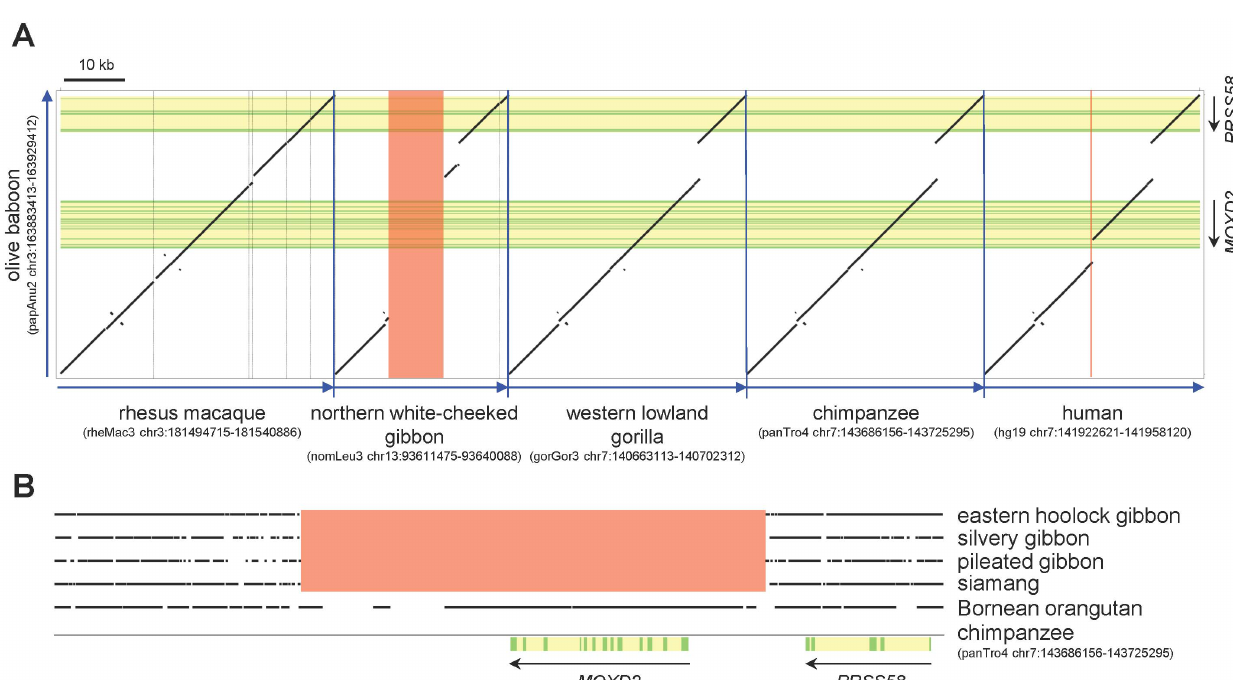
Figure 1. Phylogenetic tree of the species investigated in this study. The major groups are indicated either on the branch or to the right. Species with a mutated MOXD2 gene are indicated by color: red, gene loss by gene deletion, exon deletion, or ORF-disrupting mutations; blue, C- terminal truncation due to a 13-nt deletion in the last exon. Numbers in parentheses correspond to those in Table 1. K-Pg, Cretaceous-Paleogene boundary.